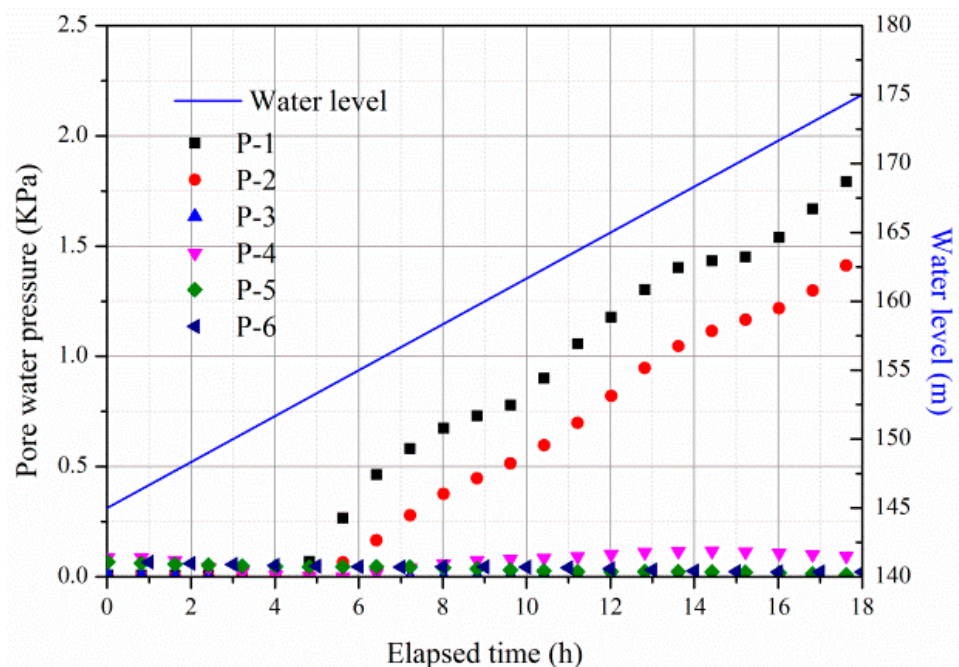
Figure 8. Pore water pressures during the rises in the water levels.